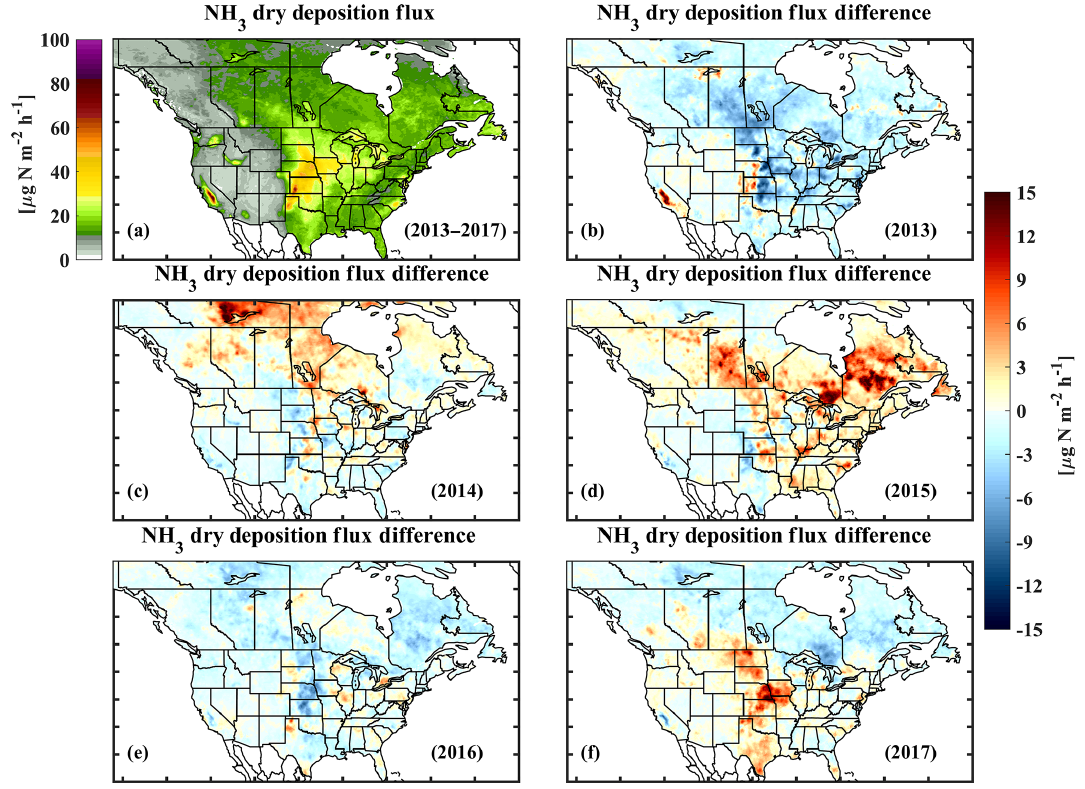
Figure 14. Plot (a) is the 5-year average (2013–2017) of the ammonia dry deposition flux over North America. Plots (b) – (f) are the differences in the NH 3 dry deposition flux for each year from the 5-year mean shown in (a)